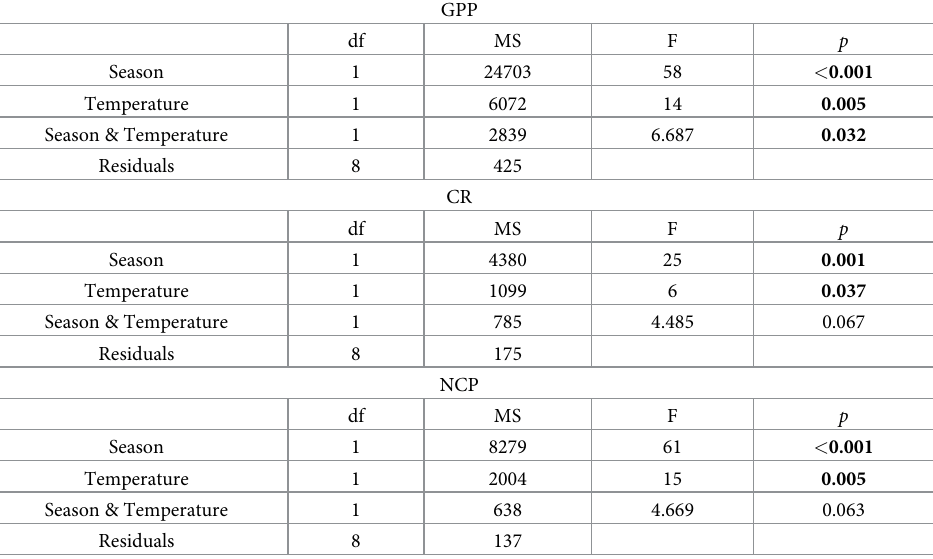
Table 2. Results of the 2–way ANOVA analysis of the factors temperature and season in the carbon community metabolism. GPP df MS F p Season 1 24703 <